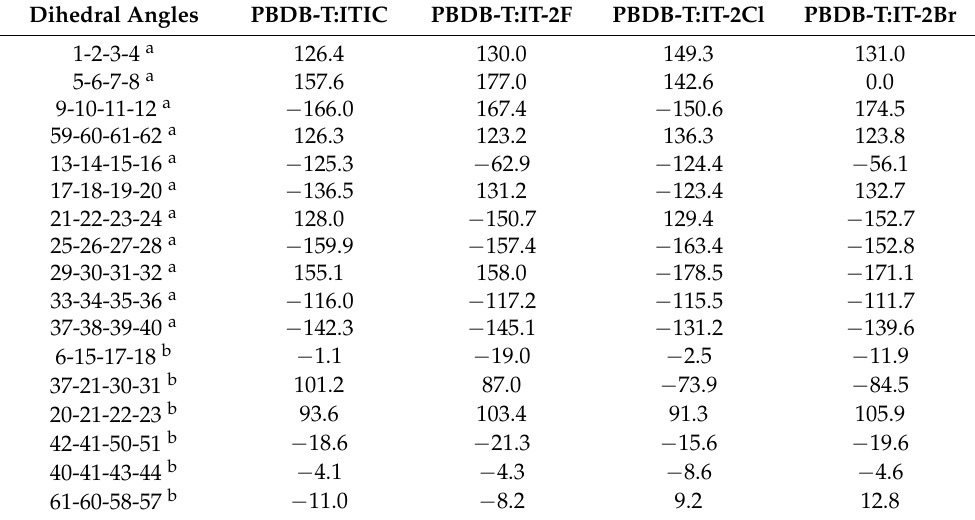
Table 4. The selected dihedral angles (in ◦ ) of PBDB-T:ITIC and PBDB-T:IT-2X (X = F, Cl, Br) complexes. The corresponding atomic serial numbers are shown Figure S1 in Supporting Material. ( ω